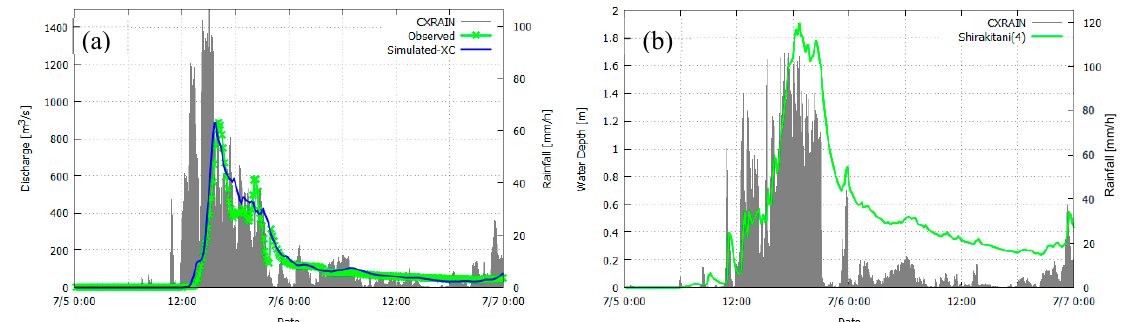
Figure 12. ( a ) RRI model calibration with observed dam inflow at Terauchi Dam, ( b ) simulated water depths at the downstream of Shirakitani River.